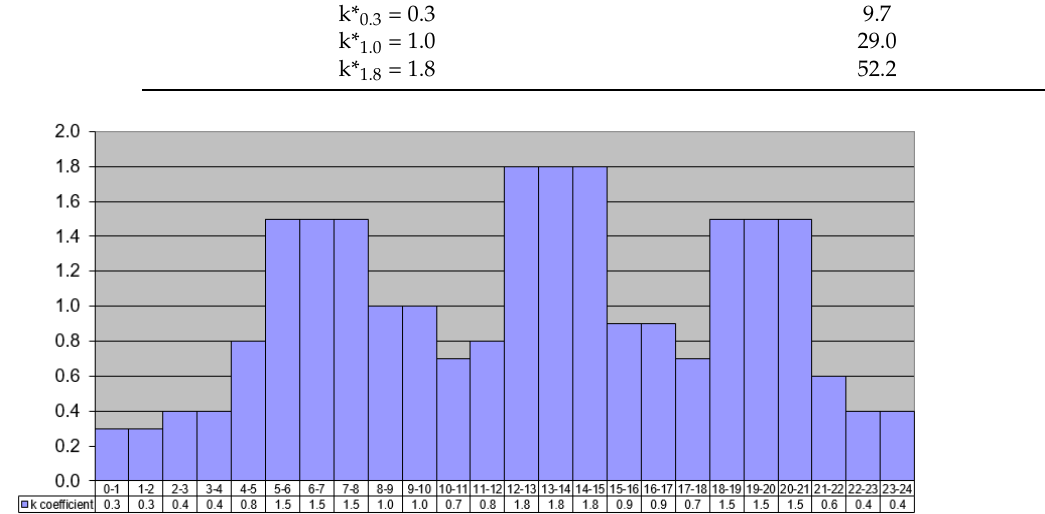
Figure 4. Pattern values assumed in extended period simulation.